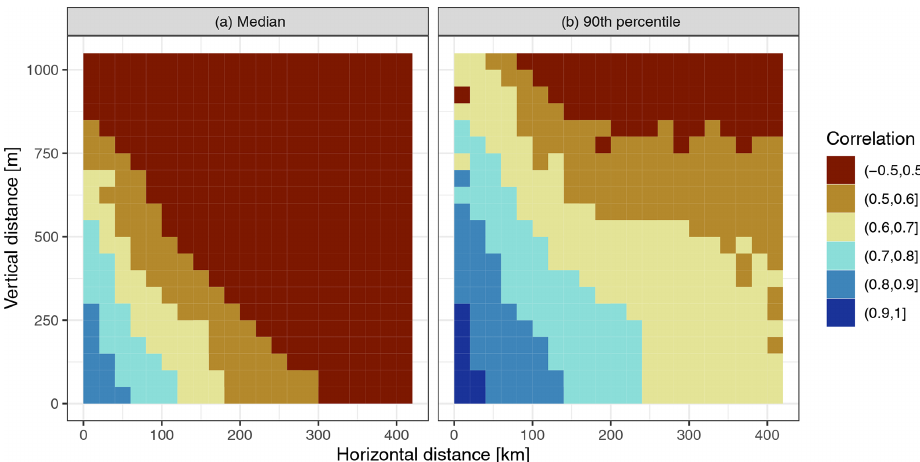
Figure A1. Summary of pairwise correlations between HS series for December to April, 1981 to 2010. The average (median, a ) and 90th percentile (b) are shown of all pairwise correlations in bins of 20km horizontal distance by bins of 50m vertical distance. The correlations were only calculated if each series had at least 70% valid data in the period and if each pair had at least 50% of data in